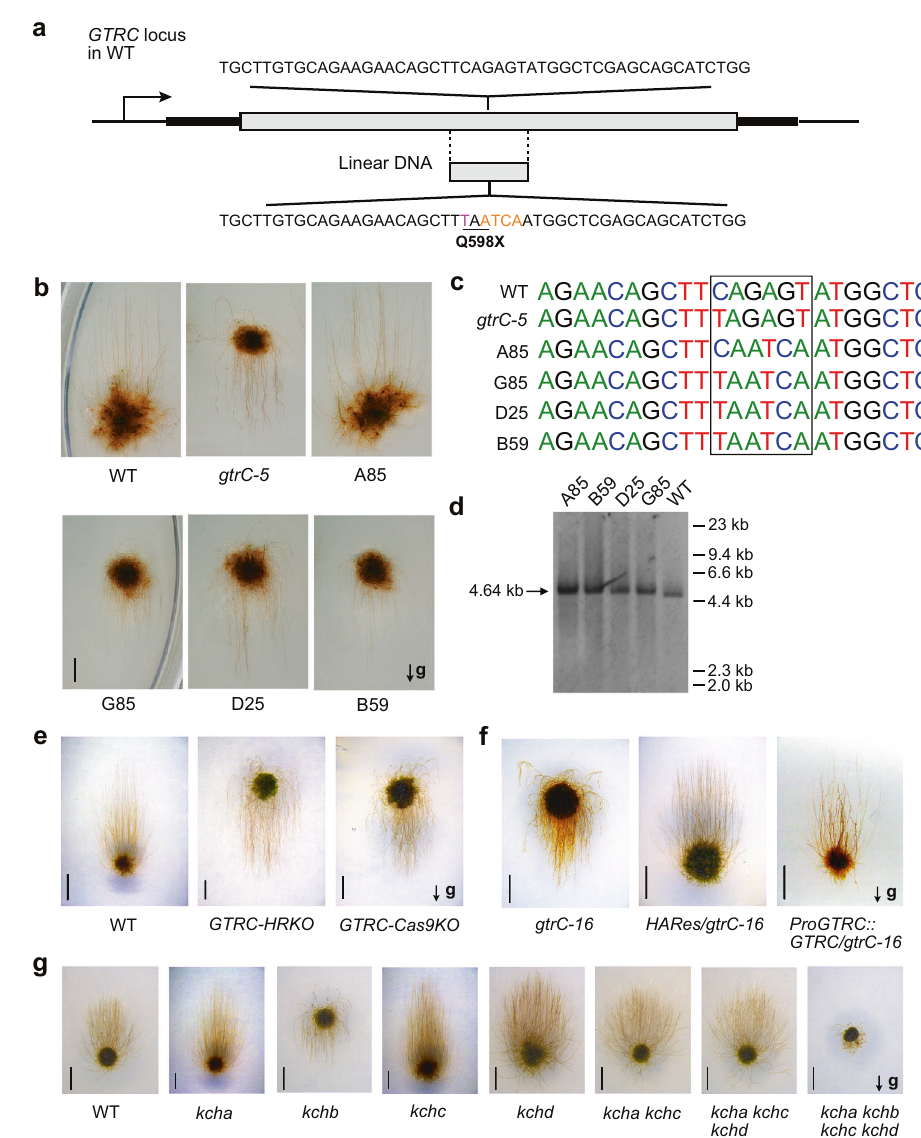
Fig. 3 Genetic con fi rmation of the GTRC locus. a – d Targeted mutagenesis of GTRC in wild type. a The native sequence encoding Q 598 was mutated to reproduce the stop codon (X) mutation identi fi ed in the gtrC-5 mutant. WT P. patens was transformed with a linear 1537-bp fragment of DNA comprising the four exons surrounding the Q 598 codon in exon 14 using a transient selection strategy. The WT and mutant sequences are shown above and below. b Gravitropism in WT, gtrC-5 and gene-targeted WT P. patens . Caulonemal growth in darkness for 3 weeks on vertical BCD agar medium. The untransformed WT and gtrC-5 mutant lines are shown in the upper panel together with a transgenic line A85 that did not alter the Q 598 residue. The lower panel shows three transgenic lines (B59, D25, and G85) with a Q598X mutation. c Sequence analysis of the mutant locus in the gene-targeted lines, compared with WT and the original gtrC-5 mutant. Lines B59, D25, and G85 contain the targeted mutation (CAGAGT > TAATCA), resulting in Q598X (CAG > TAA). Line A85 contains the targeted mutation of Ser 599 (AGT > TCA) but unmutated Q 598 (CAG > CAA). The nucleotides coding these two amino acids were labeled in the black box. d Southern blot analysis of the gene-targeted mutant lines. The genomic DNA was digested by Eco RI and then detected by labeled ssDNA. Only one band of the expected size (ca. 4.64 kb) was detected in each line, con fi rming that no off-target integration occurred. The experiment was carried out once, and the result is unambiguous. See methods for details, and source data are provided as a Source Data fi le. e Gravitropic phenotypes of knockout lines of GTRC . GTRC-HRKO was generated via homologous recombination by substituting GTRC genomic region with the NptII cassette. GTRC-Cas9KO was generated by editing the GTRC locus via CRISPR-Cas9 mutagenesis. f Gravitropic phenotypes of complementation lines of GTRC. HARes/gtrC-16 was generated by substituting the mutated nucleotide of gtrC-16 with wild-type genomic nucleotide . ProGTRC::GTRC/gtrC-16 was generated by substituting the mutated genomic DNA of GTRC in gtrC-16 with wild-type GTRC coding sequence. The details of the constructs and genotypes for the P. patens lines in e – f are shown in Supplementary Fig. 1. g Gravitropic phenotypes of knockout lines of KCH family genes. All lines except kchb ( gtrC-16 ) were generated by editing the corresponding KCH loci via CRISPR/Cas9 mutagenesis. Genotypes for these lines are shown in Supplementary Fig. 3. In ( b , e , f , g ), arrows labeled with “ g ” indicate the directions of gravity vectors, and the scale bars are 3